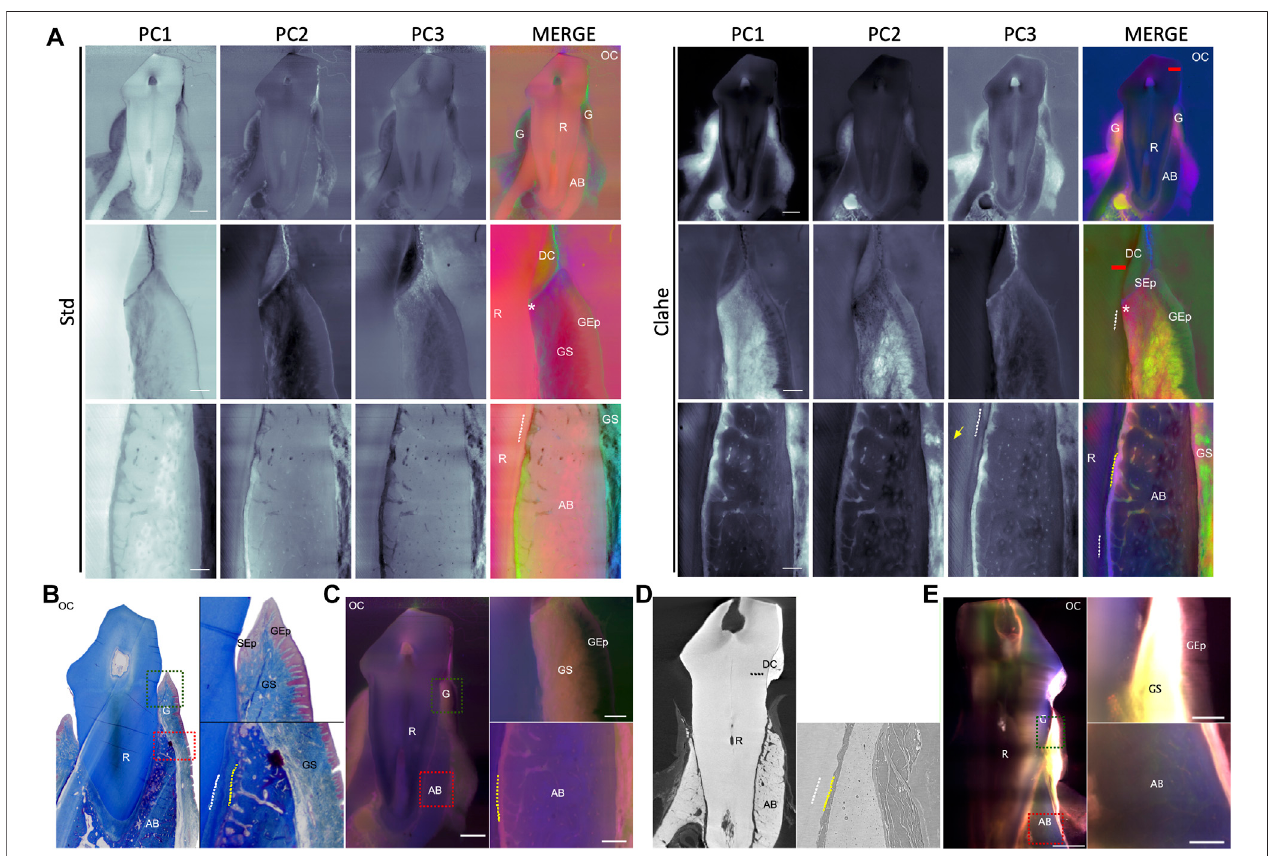
FIGURE 3 | Canine periodontal tissue identi fi cation by spectral Principal Component Analysis is con fi rmed by conventional microscopy approaches. (A) — 2-mm thick fl uorescence imaging of canine periodontal sample and spectral Principal Component Analysis (sPCA) after Std or Clahe preprocessing. Interestingly, sPCA enhancesrootcementum(whitedashedlines),gingivalstroma(GS)andperiodontalligament(PDL,yellowdashedlines),alveolarbone(AB),keratinonepitheliumsurface (green, Std, merge), intra-dentinal tubuli (orange arrow) and dental calculus (DC). OC: oral cavity. R: tooth root. G: gingiva. Gep: gingival epithelium. Sep: Sulcular epithelium. Red line: enamel-cementum junction. *: dento-gingival junction. Scale bar: 2000 µm (low magni fi cation), 500 µm (high magni fi cation). (B) — Masson ’ s trichrome staining of decalci fi ed 3 µm thickness sections at low (×10) and higher (×100) magni fi cation by optical microscopy. (C) — 2-mm-thick periodontal sample fl uorescence multi-staining imaging with optical macroscope (LEICA ® MacroFluo Z16 APO). Scale bar: 2000 µm. (D) — 2-mm thick 3D X-ray imaging of canine periodontalsampleusingZeissVersa 510microscopeat low(×0.4)andhigher (×4)magni fi cation. (E) — 2-mmthickimagingofcanineperiodontal samplebyLightSheet Fluorescence Microscopy after BABB